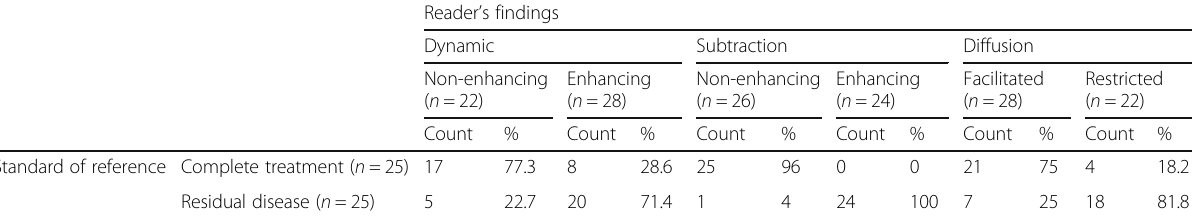
Table 4 Correlation of dynamic, subtraction, and diffusion findings obtained by reader 3 to standard of reference